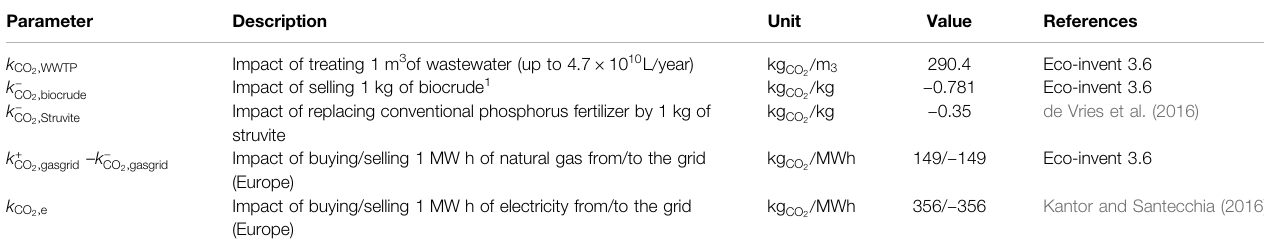
TABLE 2 | Reference environmental impacts of main